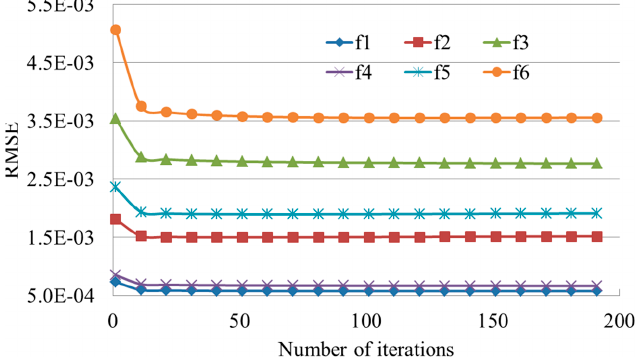
Figure 4. E ff ect of the smoothing parameter on the root mean square errors (RMSEs) of ( a ) DCT-based Figure 4. Effect of the smoothing parameter on the root mean square errors (RMSEs) of ( a ) and ( b ) proposed methods. Remote Sens. 2019 , 11 , x FOR PEER DCT-based and ( b ) proposed methods.